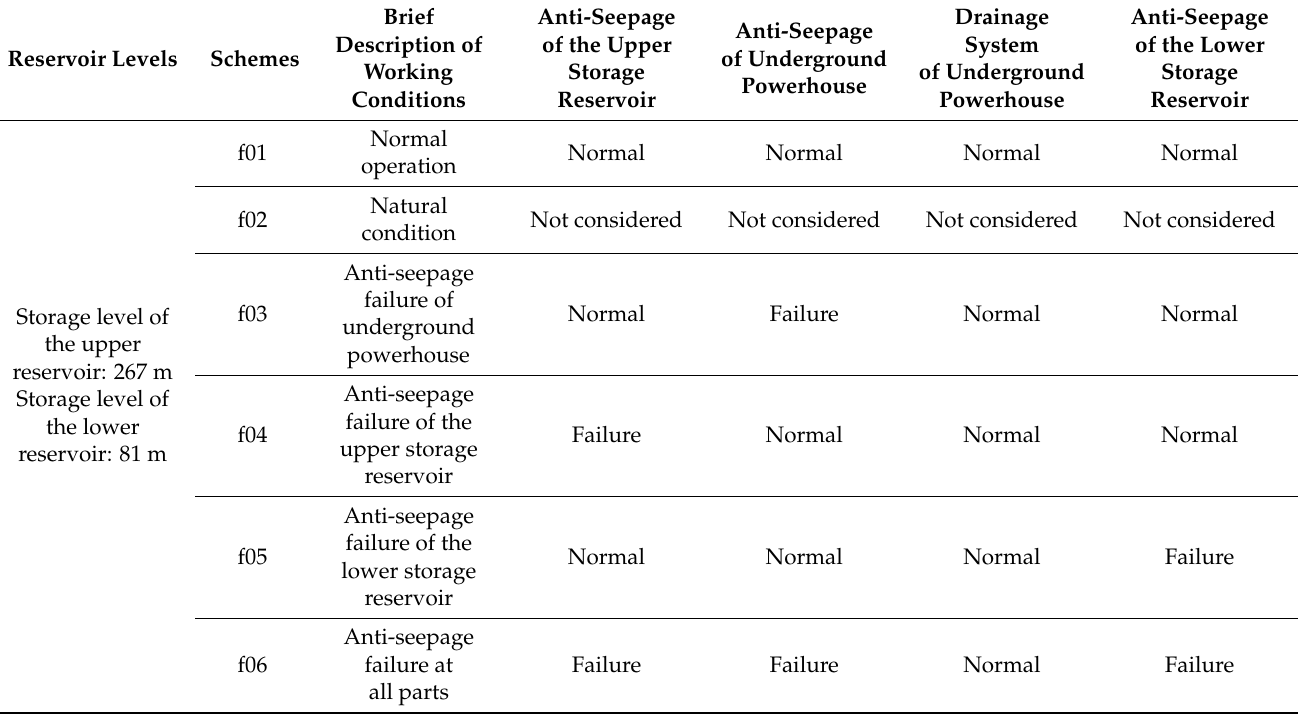
Table 4. Calculation schemes for groundwater 3D seepage